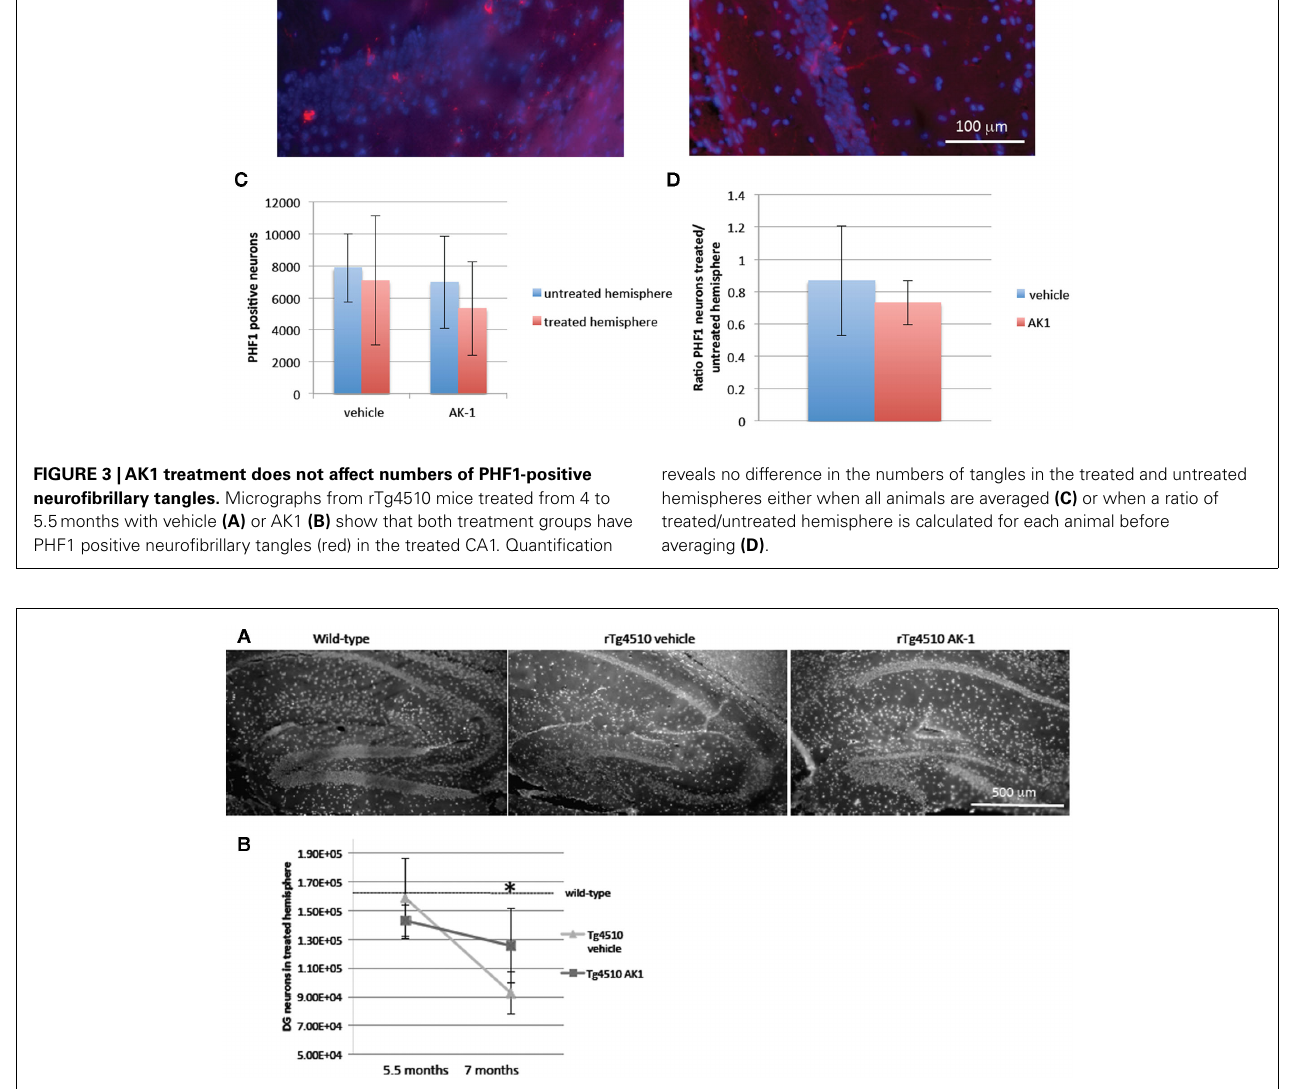
of age underwent neuronal loss, compared both to wild-type and 5.5-month-old rTg4510 animals ( B , * p < 0.05). AK1 treatment partially prevented this loss. AK1 treated rTg4510 DG does not have significant loss compared to wild-type or 5.5-month-old rTg4510